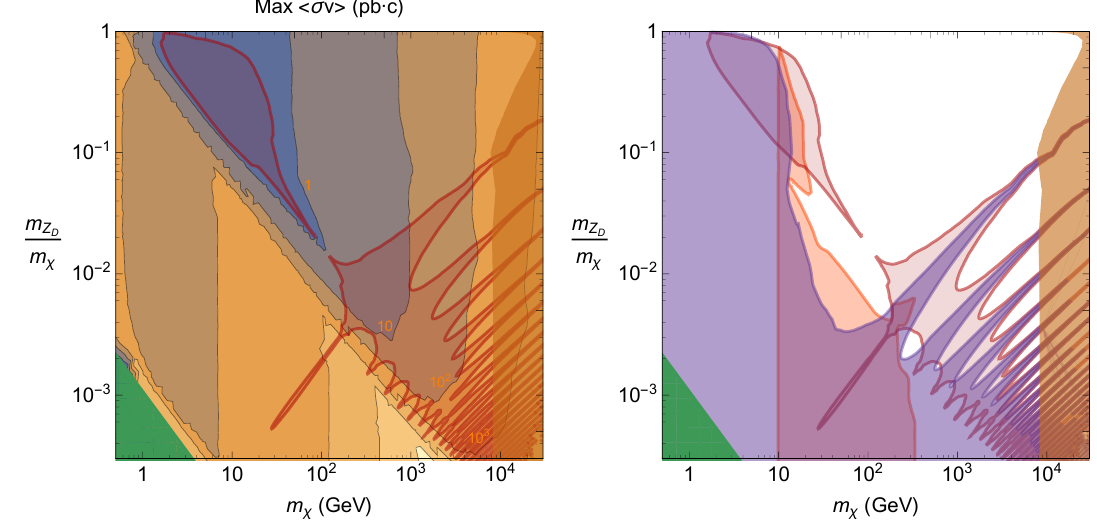
Figure 4 . Left: maximum annihilation rate (in pb (cid:1) c) consistent with the Fermi-LAT (cid:13) -ray mea- surements of dwarf galaxies [63] in the HSFO-VP model. The red regions indicate where Fermi dwarf measurements exclude the thermal relic abundance. The brown region on the right of the plot illustrates where the freezeout coupling as determined with and without Sommerfeld enhancement deviates by more than a factor of two so that the determined value of g D becomes inaccurate (B.7). The green region in the lower left is where m Z < 2 m e . Right: indirect detection bounds on the D HSFO-VP parameter space. The thermal relic abundance is excluded by Fermi dwarf (cid:13) s (red), positrons at AMS-02 (orange) [45], and CMB spectral distortions from Planck, SPT, ACT, and WMAP (purple). The constraints are sensitive to the precise locations of the Sommerfeld reso- nances in the lower right region, which are here only approximately determined. Brown and green regions as in the left